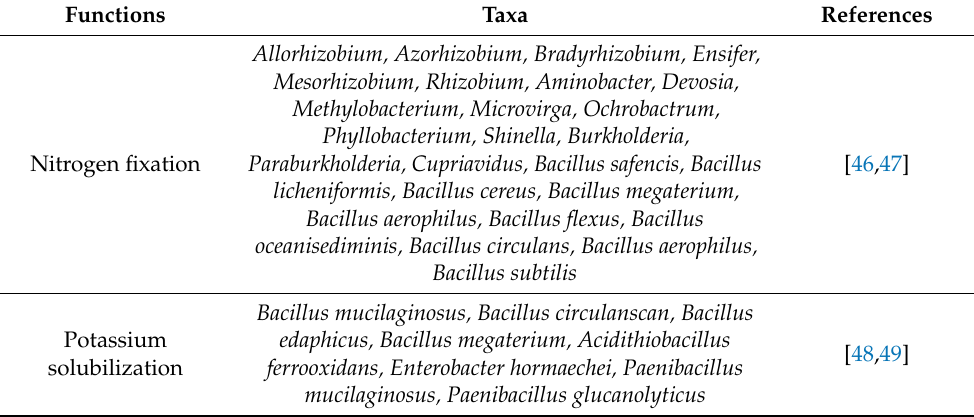
Table 1. A list of bacterial taxa capable of nitrogen fixation, phosphate and potassium solubilization.